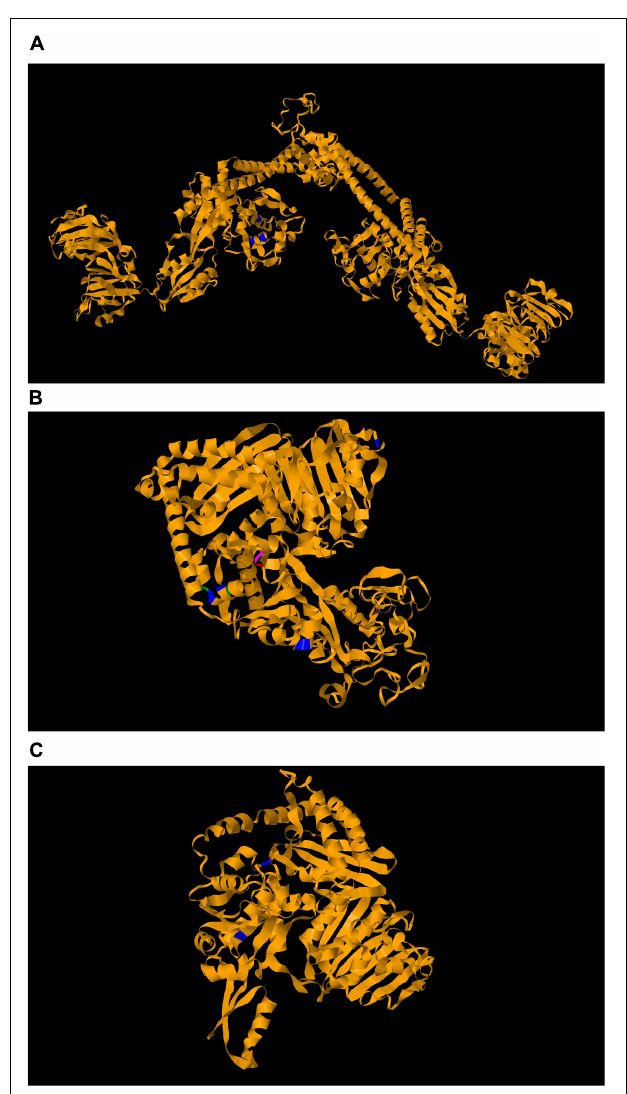
FIGURE 2 | DNA gyrase in Francisella , showing critical residues. The Francisella tularensis tularensis ScuS4 GyrA (A) , GyrB (B) , and ParE (C) amino acid sequences were used in conjugation with SwissModel (Schwede et al., 2003) to generate three-dimensional protein models. The model of each with the highest global model quality estimation score is presented here in orange. On each model, mutations leading to enhanced resistance were mapped. Blue indicates a substitution of residue, red a deletion, green an insertion after the indicated residue, and magenta either a deletion or a substitution at that residue. Protein models were built in SWISS-MODEL and illustrated in Geneious (Schwede et al., 2003; Kearse et al., 2012).